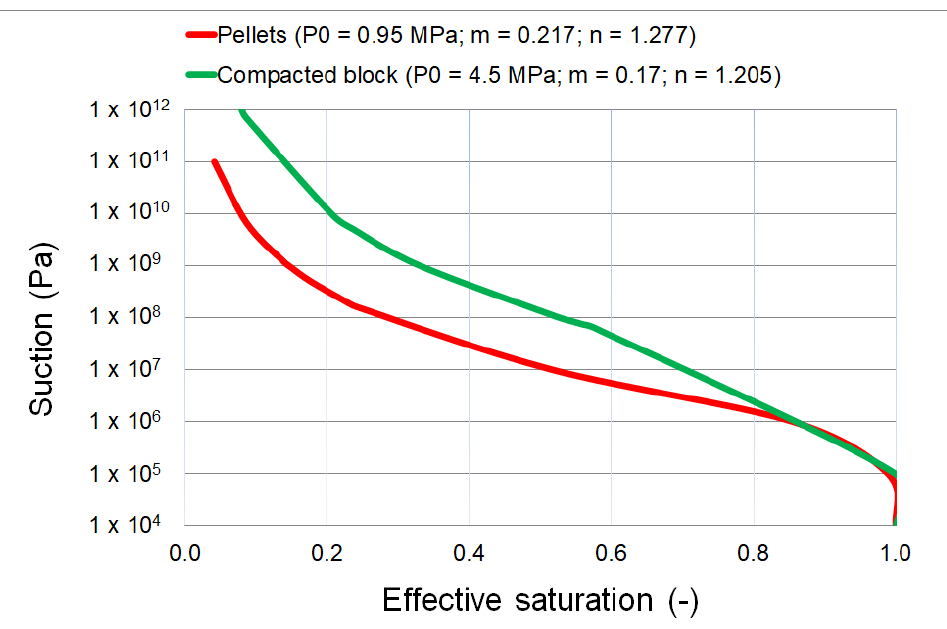
Figure 1. Capillary pressure curves for the FEBEX bentonite block and pellets applied in the model.